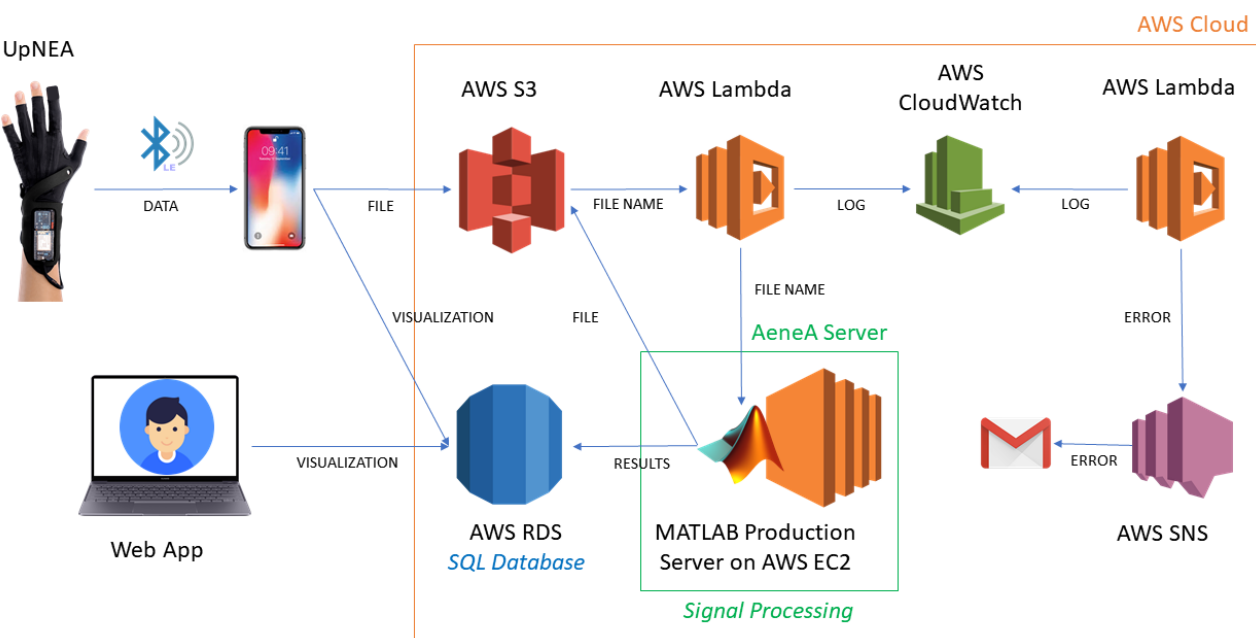
Figure 3. UpNEA AWS architecture for cloud stream and computing, refer to text for further details. After processing, all the results labeled with the user-ID and sleep session time are recorded in an AWS Relational Database Service (RDS) for Microsoft SQL database, with one-minute resolution: the heart rate and breathing rate are